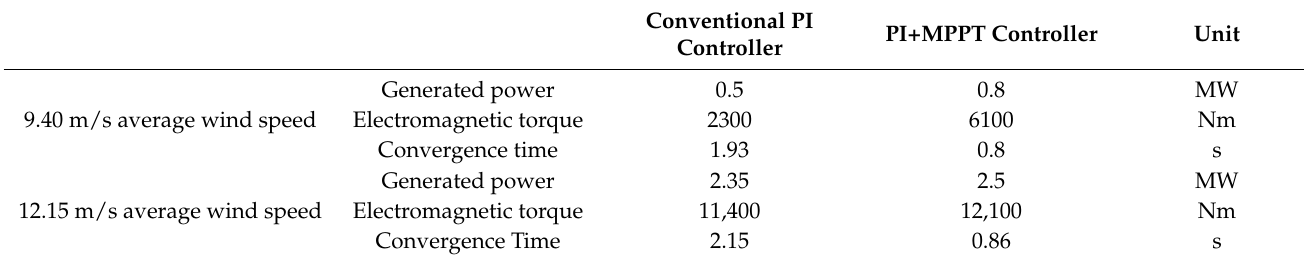
Table 2. Comparison table (at 20